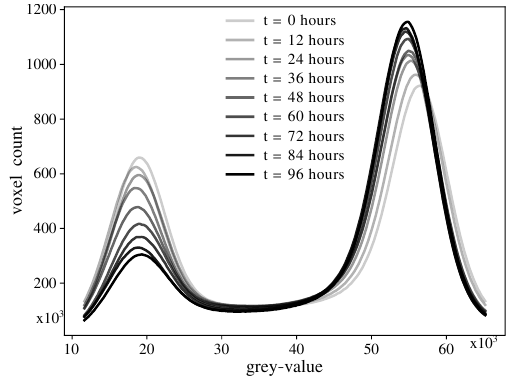
Figure 3. Grey-value histograms of the acquired images at dif- ferent times during a